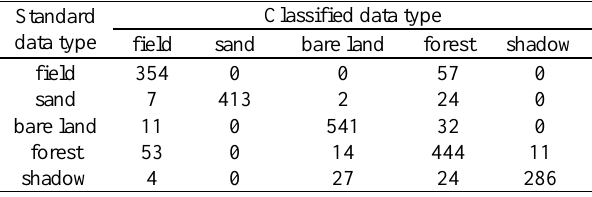
Table 3. Error matrix of 1-V-R SVMs classification